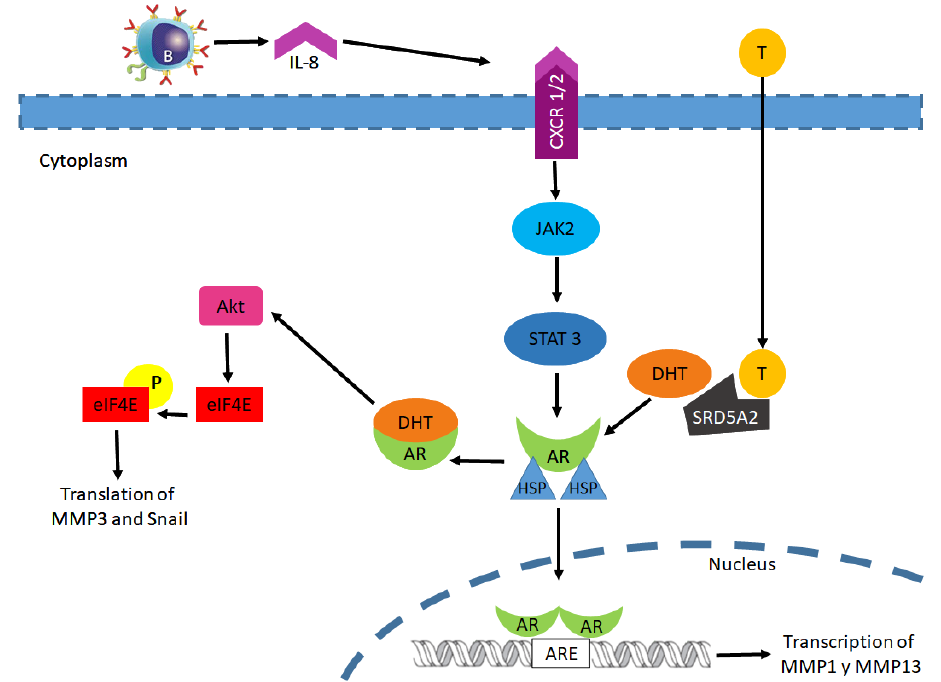
Figure 3. Androgen receptor non-genomic signaling pathway in the progression of bladder cancer.